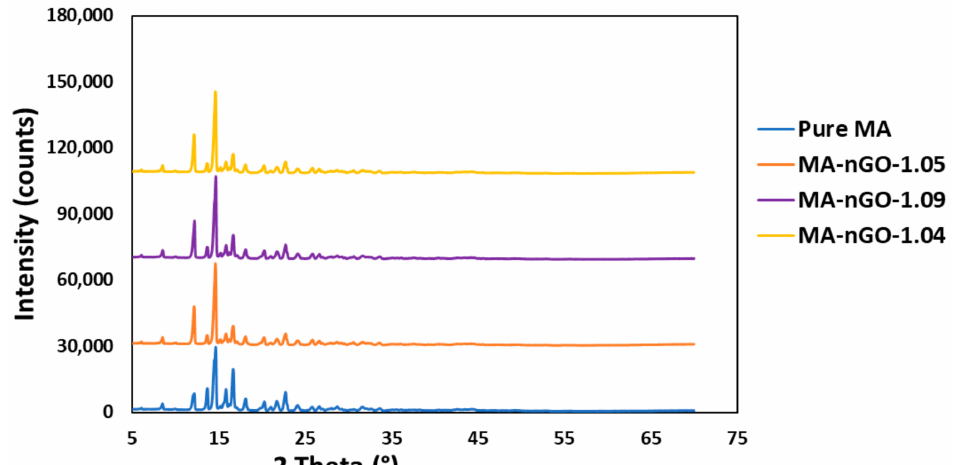
Figure 7. XRD analysis of MA and MA-nGO composites particles.